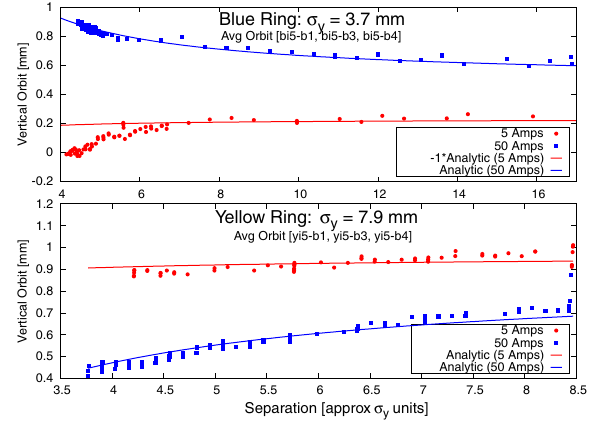
vertical dipole kick (cid:3) y 0 and vertical tune change (cid:3) Q y due